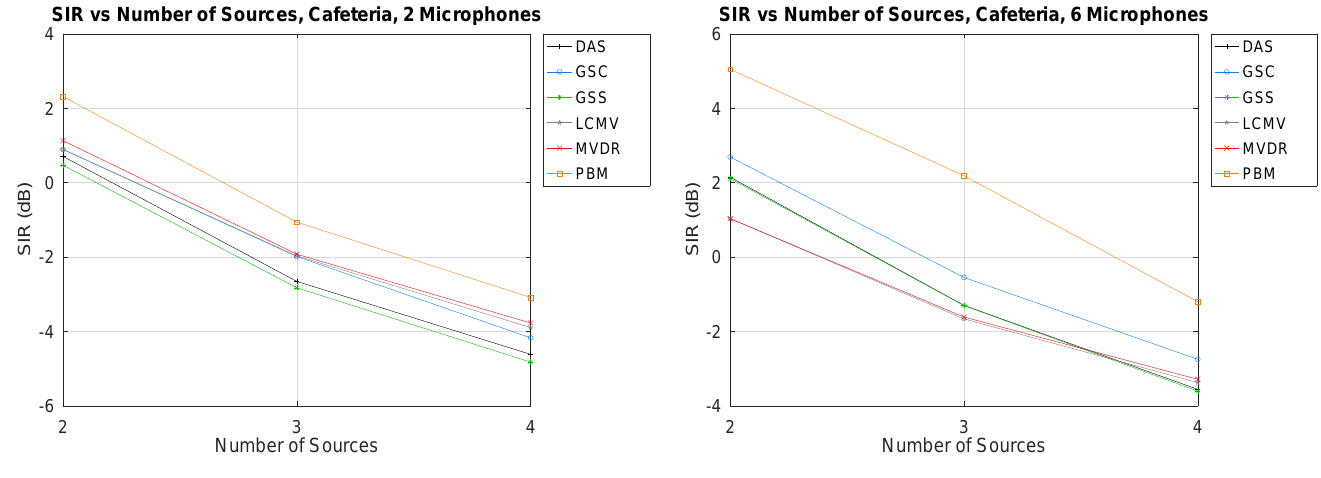
Figure 5. SIR vs. Number of